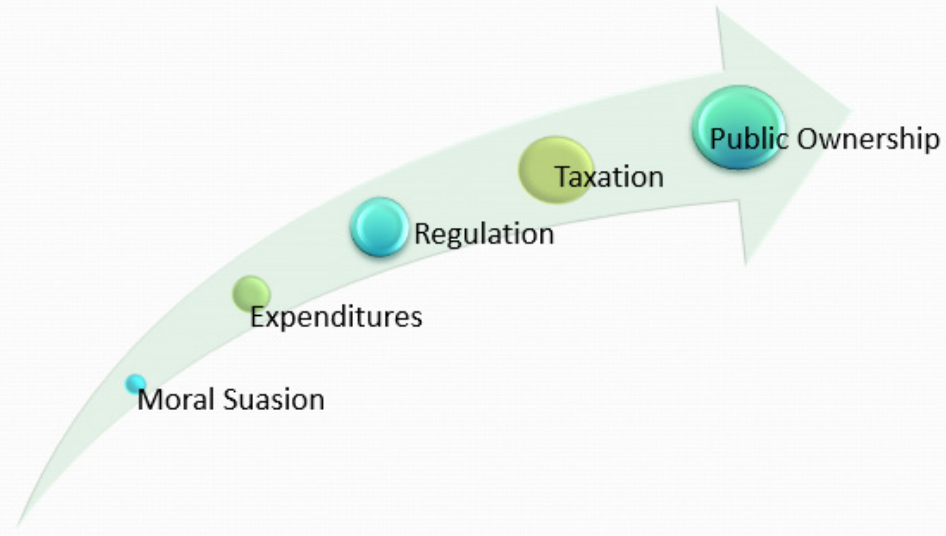
Figure 4. The Policy Continuum of Coercion [39] .